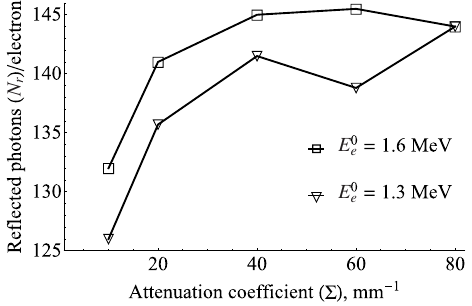
Fig. 5. Transmitted photons through a slab of thickness D ¼ 5 : 0 mm and D ¼ 10 : 0 mm and their dependence on the electron incident energy ( (cid:2) ¼ 10 : 0 mm (cid:1) 1 , a ¼ 0 : 99, g ¼ 0 :